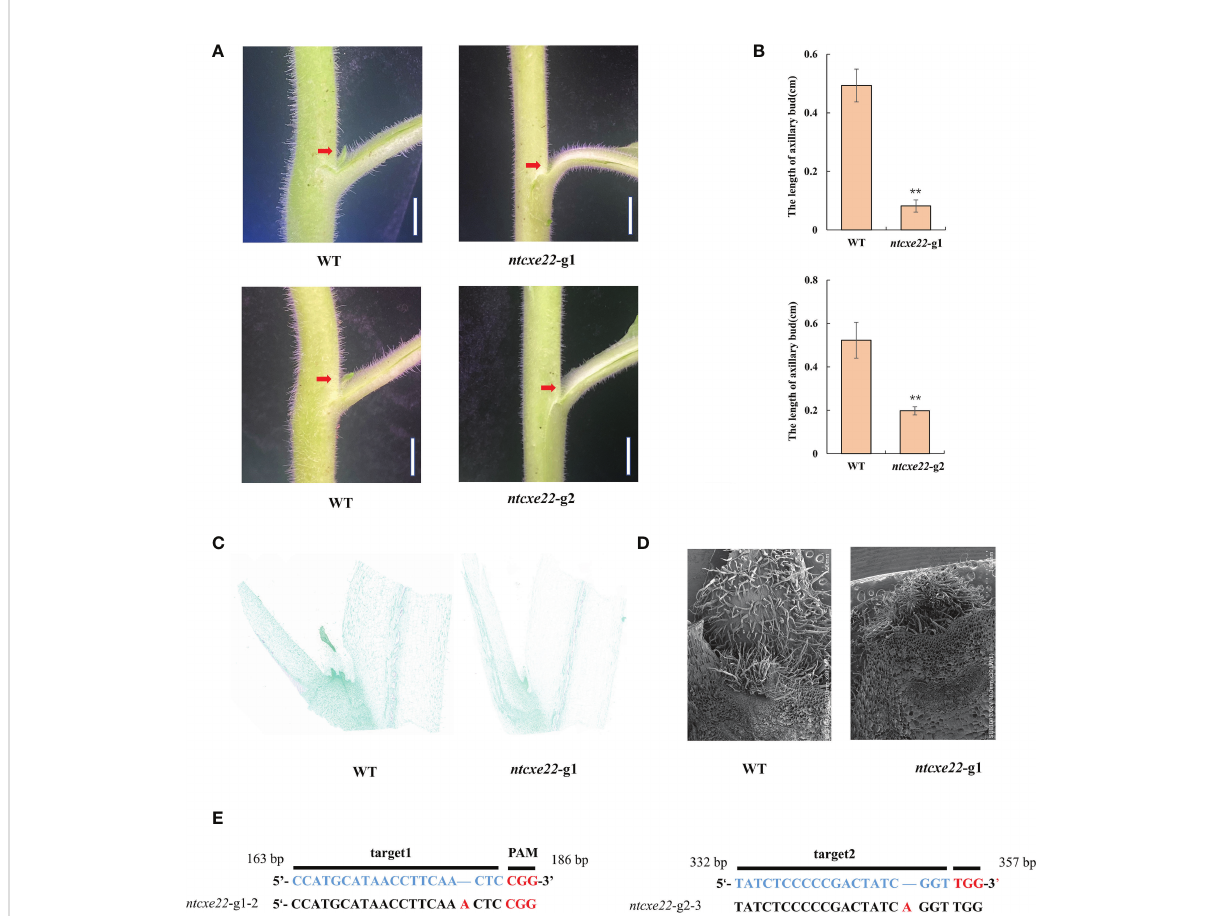
FIGURE 9 CRISPR/Cas9-mediated gene editing of NtCXE22 in tobacco. (A) Appearance of visible axillary buds in the wild type and NtCXE22 mutant ( ntcxe22 ) tobacco seedings. Scale bar = 1 cm. Phenotypes of the whole plants were shown in Supplementary Figures 13, 14. (B) Quantitative analysis of axillary bud length in the wild type and ntcxe22 tobacco seedings. Data are presented as means ± SDs (n = 3). *P < 0.05, **P < 0.01 (signi fi cant difference relative to controls based on Student ’ s t-test). (C) Paraf fi n section of axillary bud in the wild type and ntcxe22 tobacco seedings. (D) Scanning electron micrograph of axillary bud in the wild type and ntcxe22 tobacco seedings. (E) Target locations in NtCXE22 are marked with blue letters, the protospacer adjacent motif (PAM) with red letters, and mutations in ntcxe22 -g1 and ntcxe22 -g2 are also